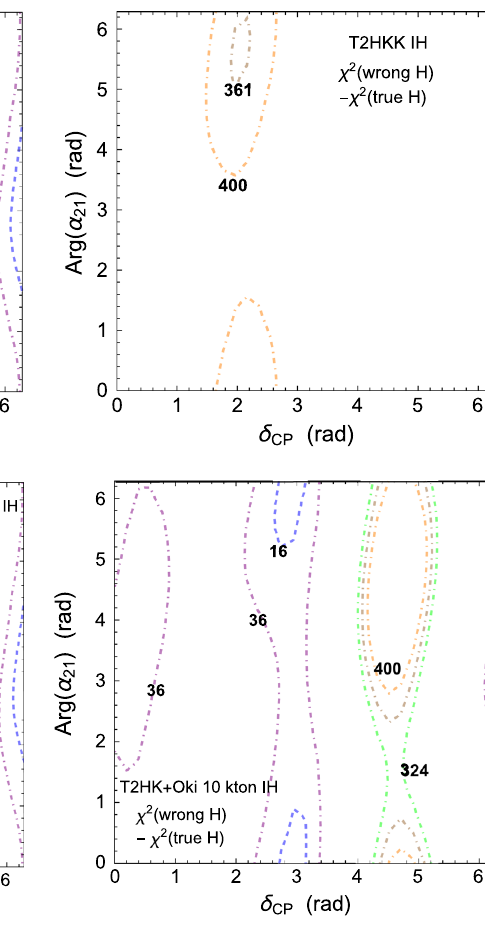
plot for a plan of the T2HK plus a 10 kton water Cerenkov detector at Kamioka. { min χ 2 ( wrong H ) − min χ 2 ( true H ) } = 4 , 16 , 36 on the redsolid,bluedashed,andpurpledot-dashedcontours,respectively,and { min χ 2 ( wrong H ) − min χ 2 ( true H ) } = 18 2 , 19 2 , 20 2 on the green, brown, and orange dot-dashed contours, respectively. The black-filled regions are where the wrong mass hierarchy is favored over the